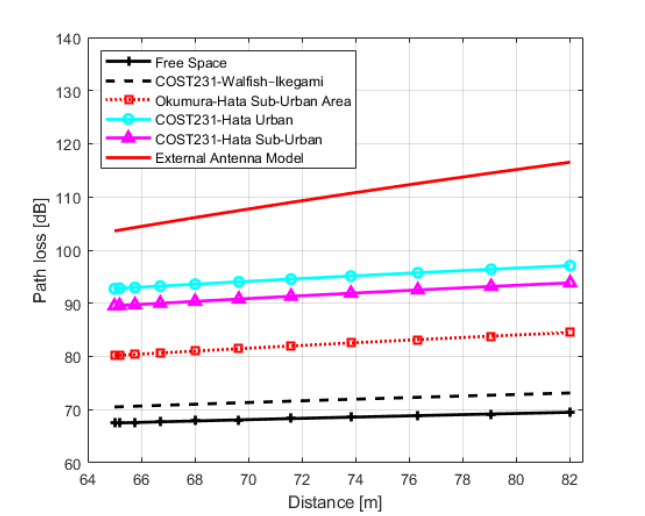
Figure 13. IQRF path loss model comparison with other models for Non-Line-of-Sight scenario